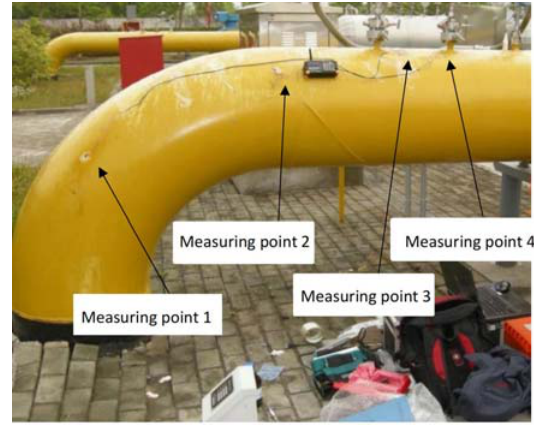
Figure 9. Distribution of field measuring points.